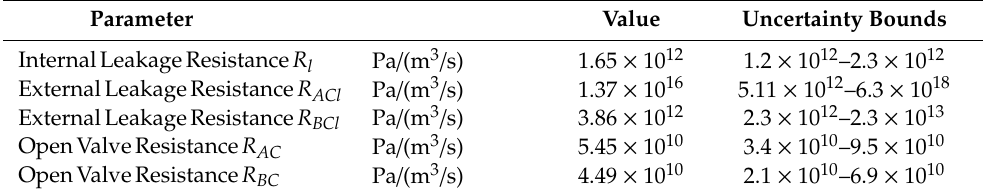
Table 3. Best fit parameters for Valve A (sleeved spool).